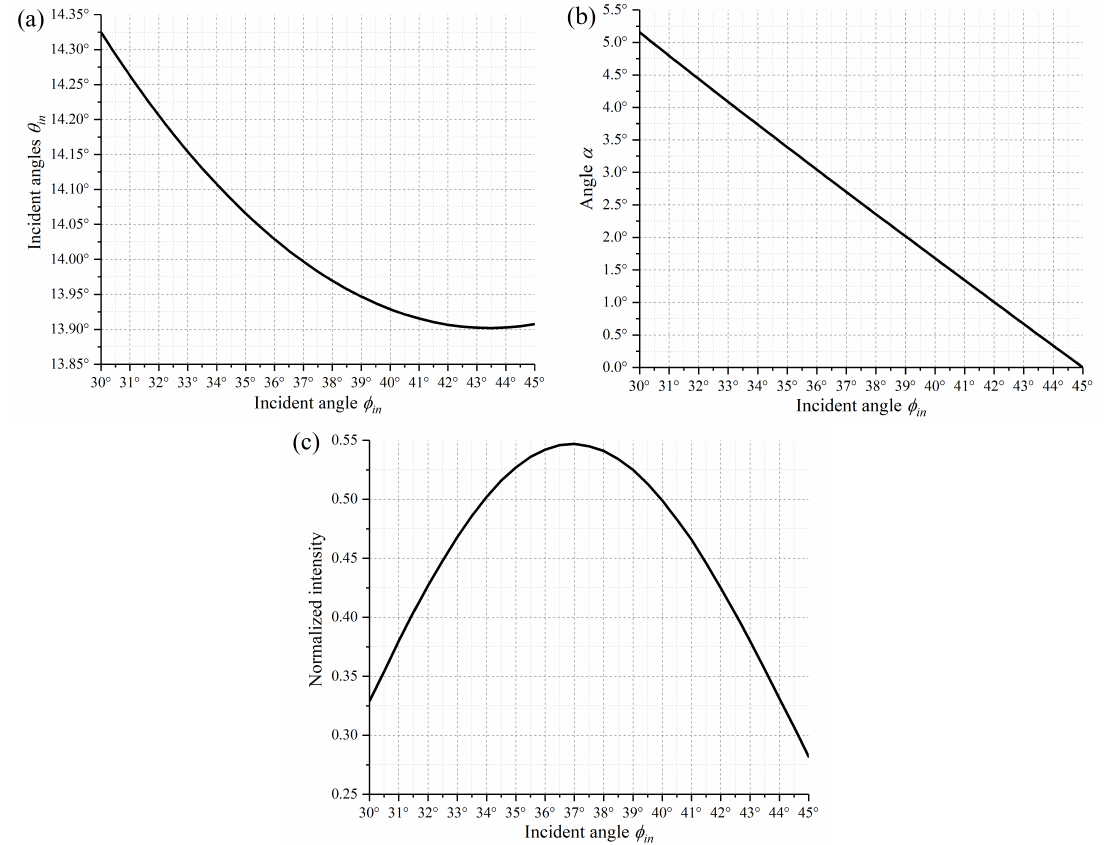
Figure 4. ( a ) Optimal incident angles ( θ in / φ in ) for the optical system. ( b ) Dependence of the angle α on the incident angles θ in . ( c ) Dependence of the normalized intensity of output beam on incident angles θ in .